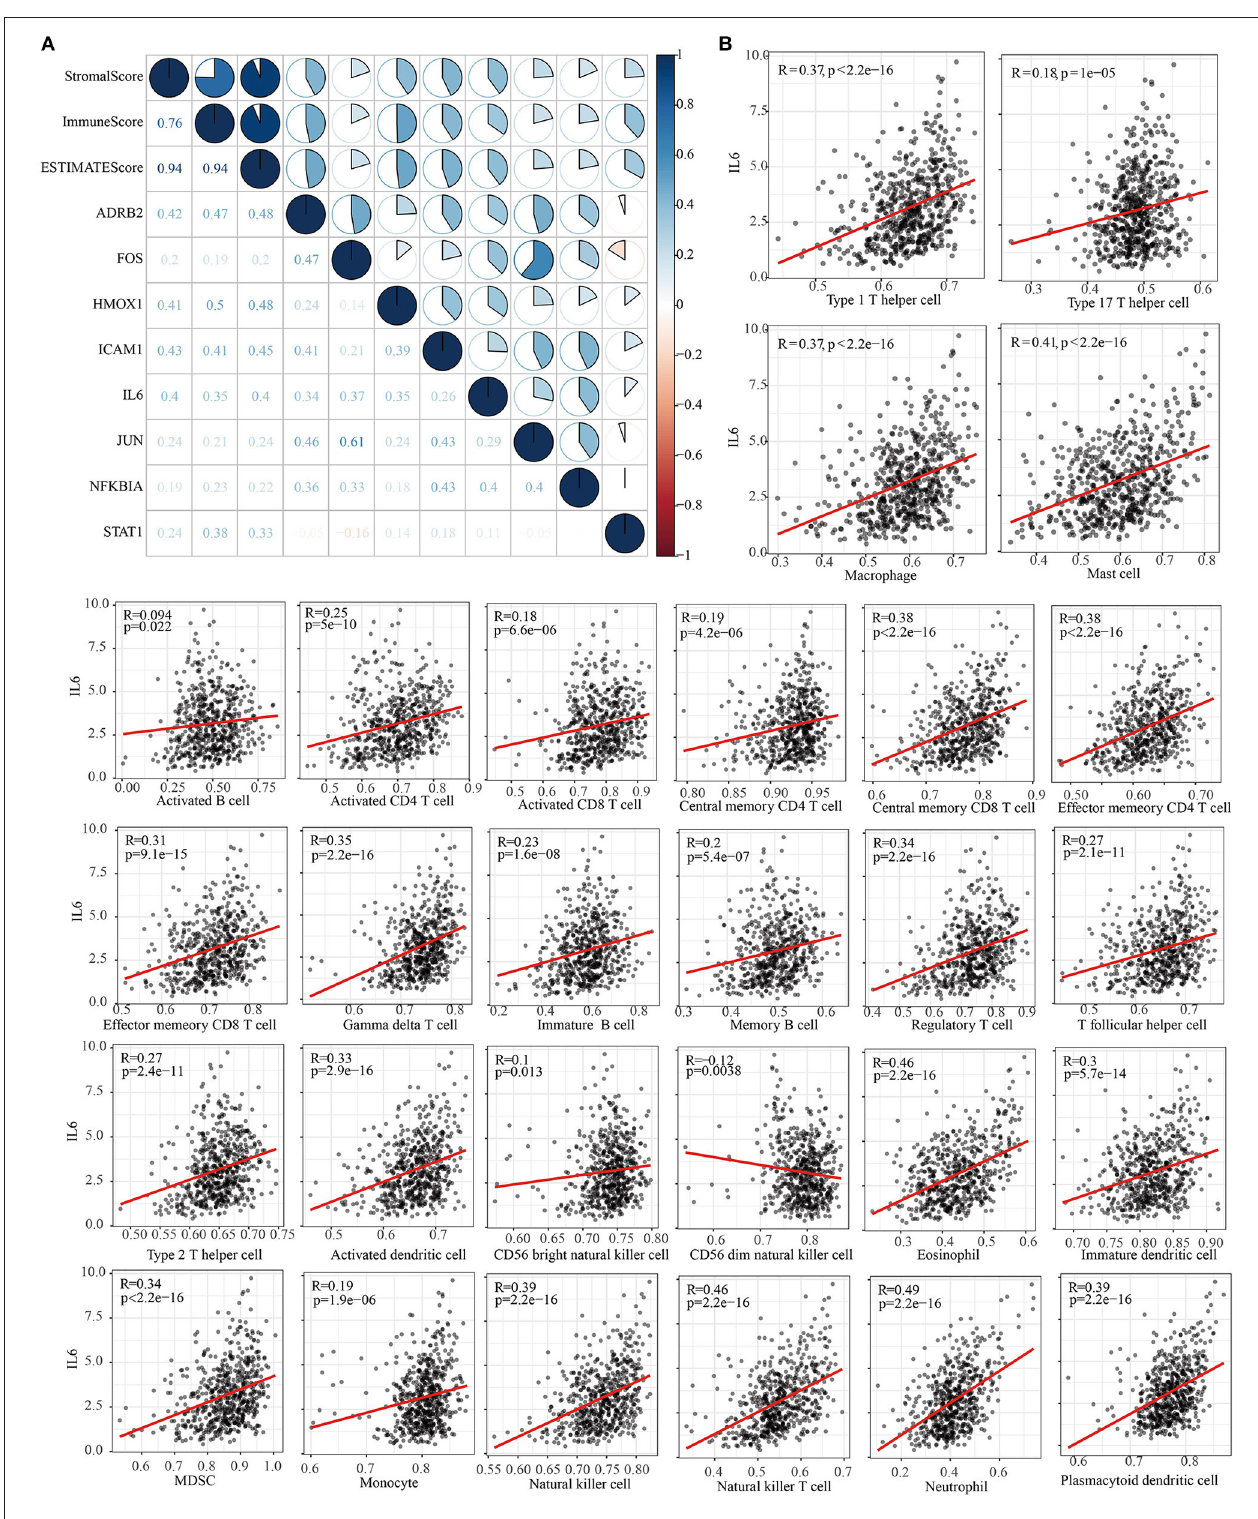
FIGURE 5 | Correlation analysis between immune target genes and TME in Chinese medicine prescription. (A) Correlation between immune target genes and stromal score, immune score, and ESTIMATE score in Chinese medicine prescription. (B) Pearson correlation analysis between IL6 expression level and ssGSEA score of 28 immune